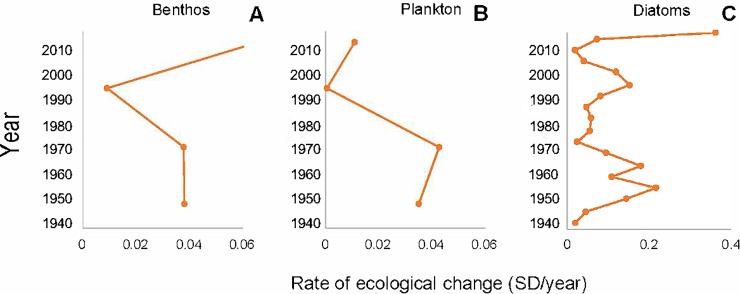
Rates of change of bioindicators.Euclidean distance between contiguous samples in terms of their ordination on the DCA rescaled ecological space; units are standard deviation (SD) as a metric for rate of change (RoC) calculated for the Inca Coya record for (a) benthic invertebrates, (b) plankton (diapausing eggs in the egg bank) and (c) diatoms identified in Inca Coya core.